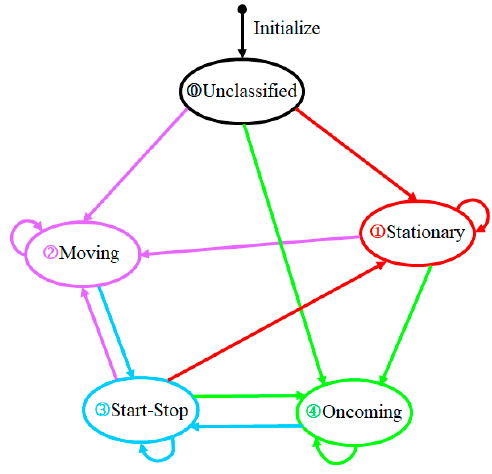
Figure 2. The flow chart of movement state transfer of the target vehicle.